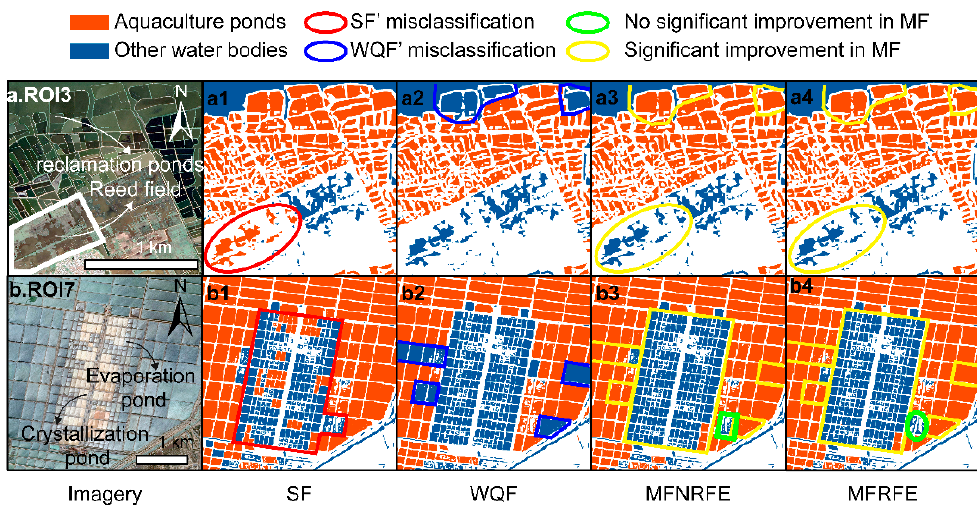
Figure 5. The performance of the four test feature combinations on site 3 and site 7. ( a1 – a4 ) represents the SF, WQF, MFNRFE, and MFRFE classification results on site 3 ( a ), ( b1 – b4 ) represents the SF, WQF, MFNRFE, and MFRFE classification results on site 7 ( b ).